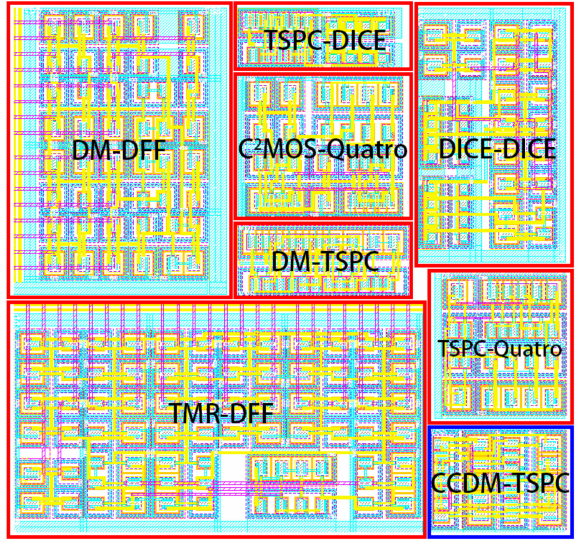
Figure 21. Layout design of the mentioned radiation-hardened